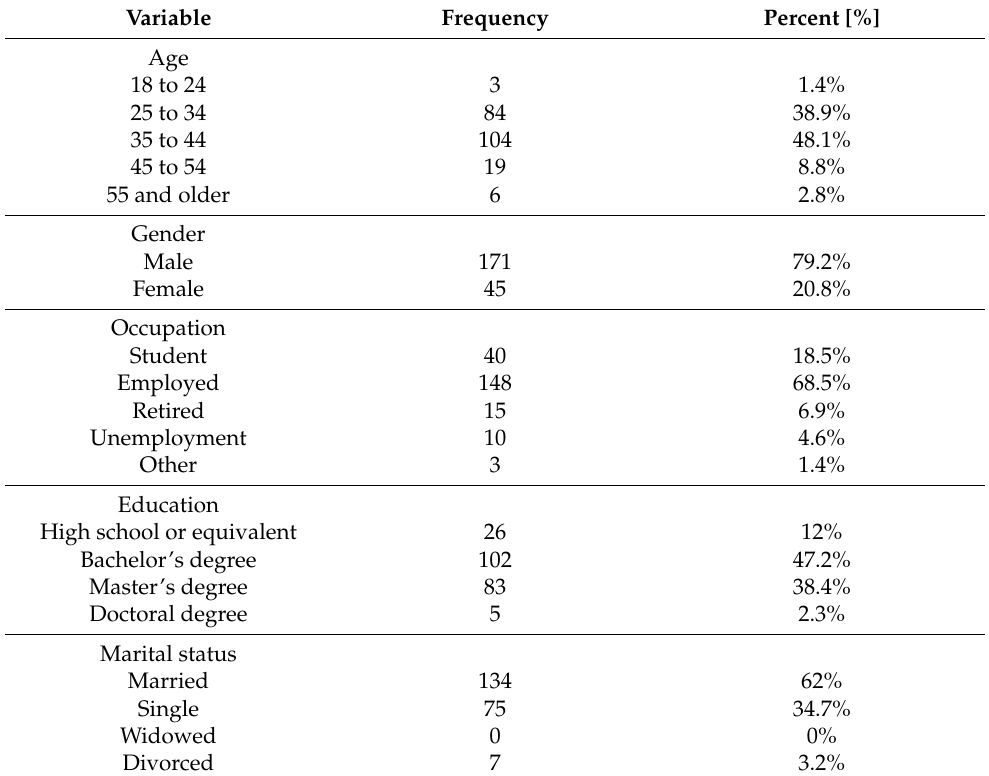
Table 1. Demographics of the collected sample ( N =